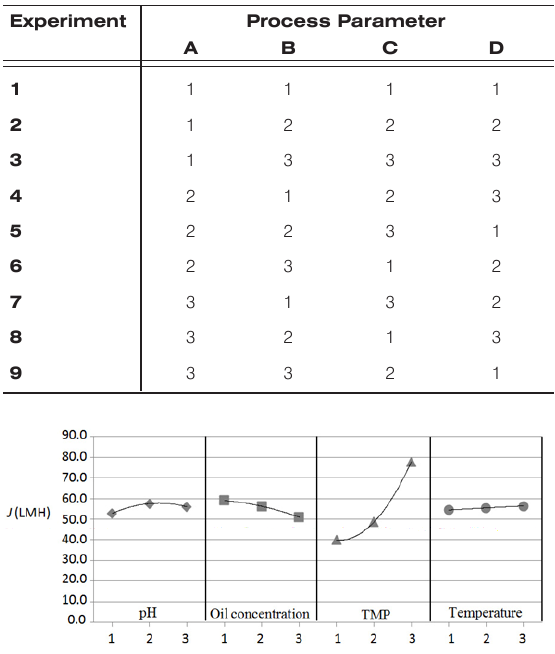
Figure 2. Influence of the individual process parameters on permeates flux at different